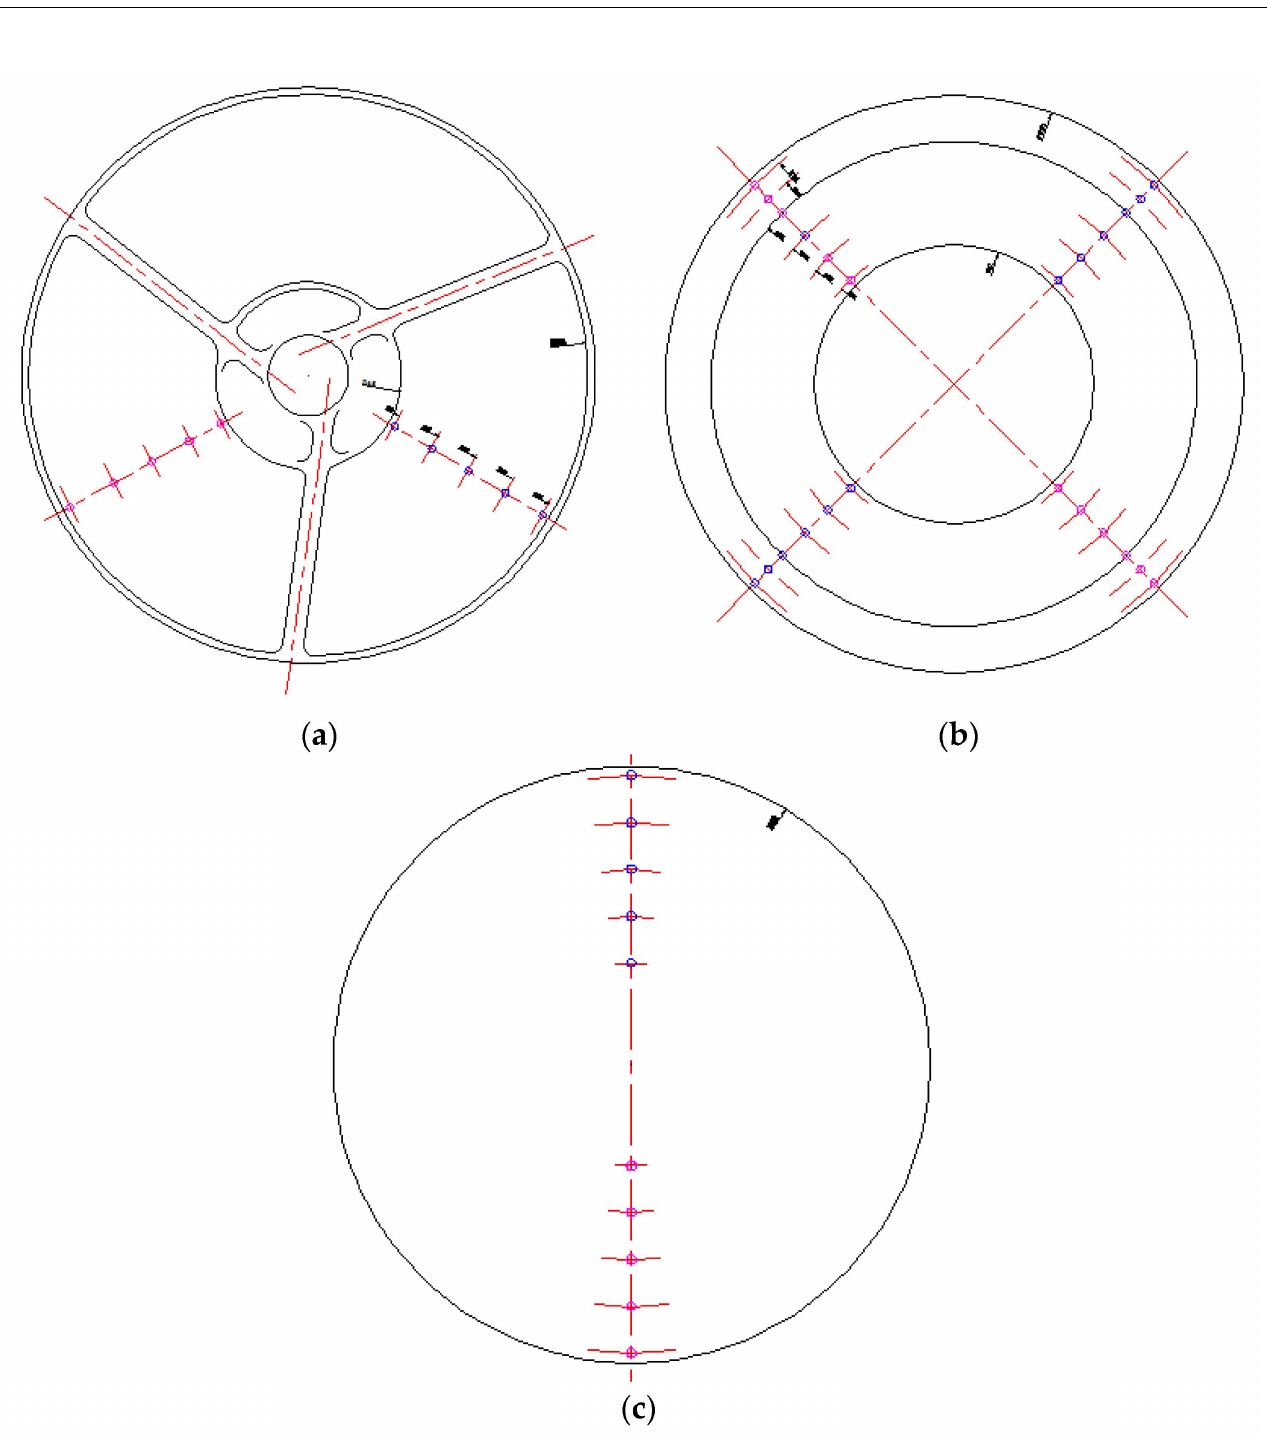
Figure 5. Circumferential distribution of measuring points in: ( a ) Section 1, ( b ) Section 2, ( c ) Section 6. The average of the data at the same measuring point and the circumferential average of the parameters are both obtained by the arithmetical average method, so that the average span-wise distribution of the parameters (total temperature, total pressure) and the average section parameters (static pressure) can be obtained. The acquisition of section average parameters requires an area average of span-wise distribution parameters. In this study, the parameters between adjacent span-wise positions are assumed to be linearly distributed. The parameters are assumed to be uniformly distributed in the boundary layer, and